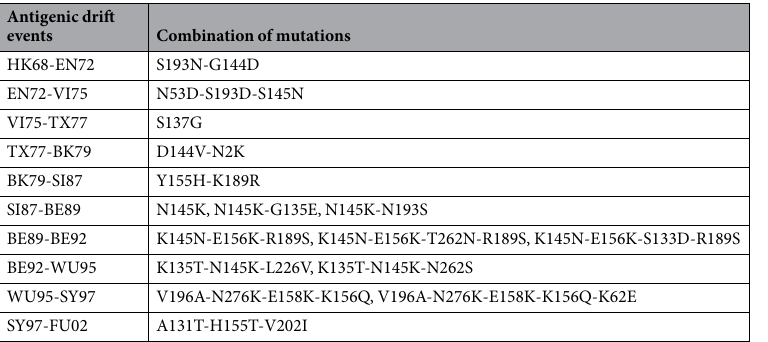
Antigenic drift events